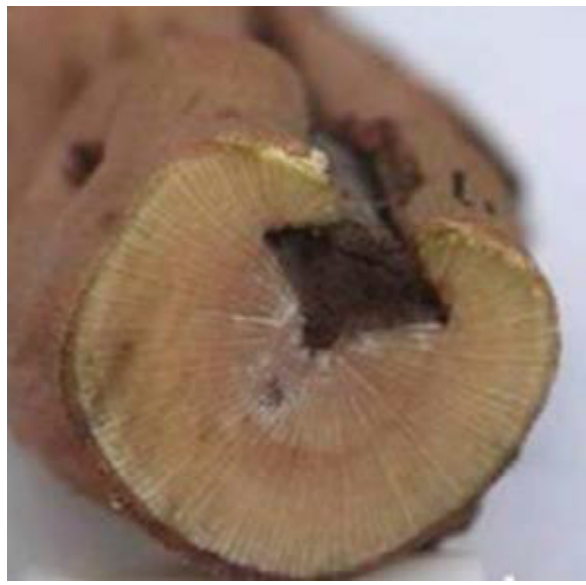
Figure 1. Brown necrosis caused by Neofusicoccum parvum in a grapevine stem cross